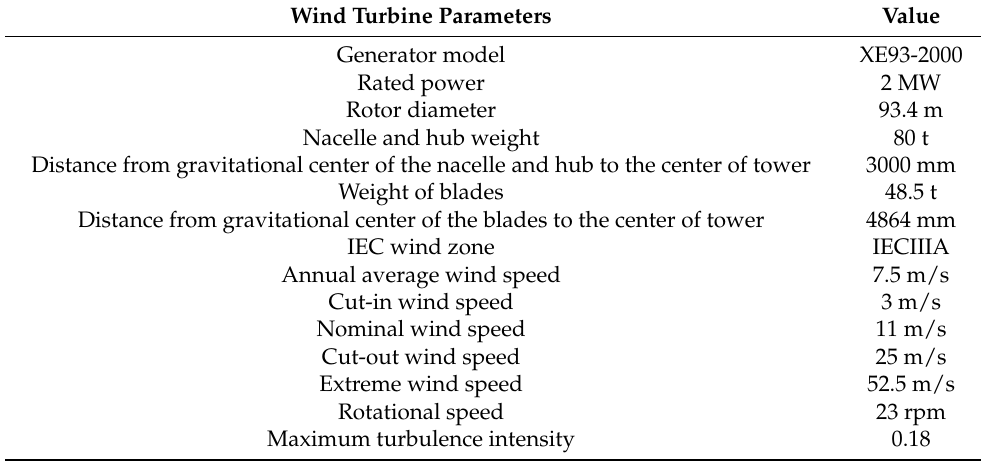
Table 4. Parameters of the wind turbine.